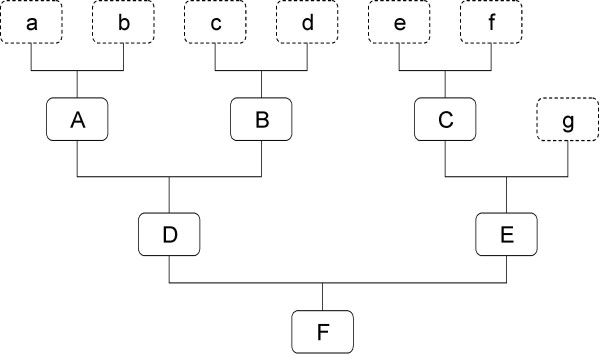
Pedigree example.